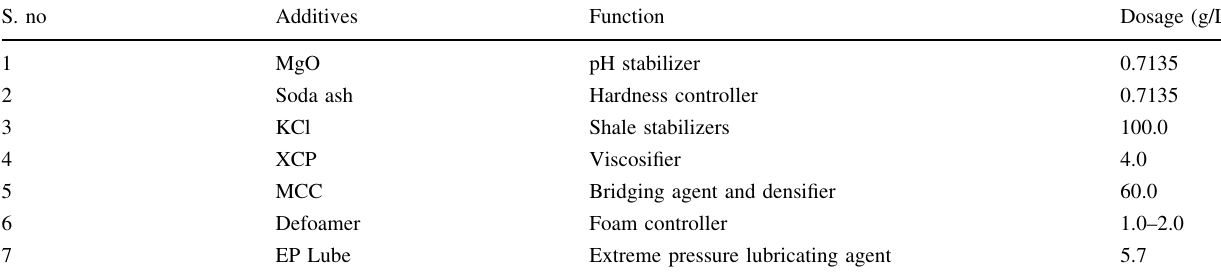
Table 1 Mud additives, functions and dosage of base mud-1 formulation S. no